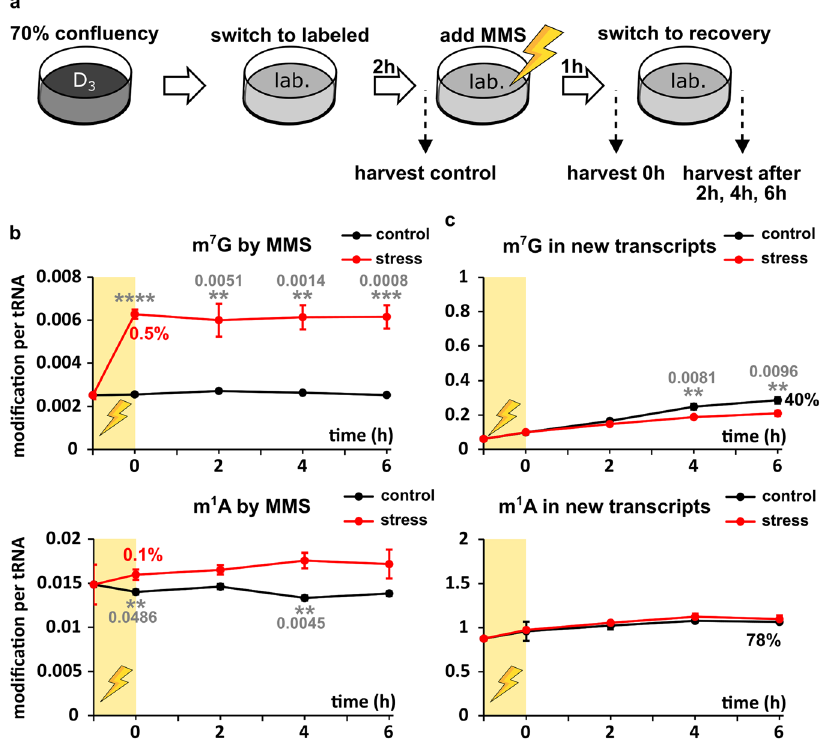
Fig. 6 Effect of methylation stress on tRNA modi fi cations. a 70% con fl uent CD 3 -methionine labeled cells were incubated with fully labeled media for 2 h before the LD 50 dose of methyl methanesulfonate (MMS, yellow shaded area) was added. Control samples were treated the same, substituting the MMS stock solution with PBS. After 1 h the stress (or control) media was replaced by fresh labeled media. After set time points, cells were harvested and tRNA Phe GAA was puri fi ed and subjected to LC-MS/MS analysis. b Unlabeled modi fi cations were referenced to unlabeled canonicals to calculate the amount of modi fi cations arising from direct methylation damage by MMS. Red numbers at time point 0 give the percentage of damaged nucleoside referenced to the naturally occurring amount of the respective modi fi cation (amount of original modi fi cation before experiment initiation). c Labeled modi fi cations were referenced to labeled canonicals to calculate the amount of modi fi cation in new tRNA transcripts. The numbers at time point 6 give the percentage of modi fi cation amount in the control sample referenced to the naturally occurring amount of the respective modi fi cation. All experiments are from n = 3 biol. replicates. Symbols re fl ect the mean and error bars re fl ect standard deviation. P -values from student t-test (equal distribution, two-sided): * p < 0.05, ** p